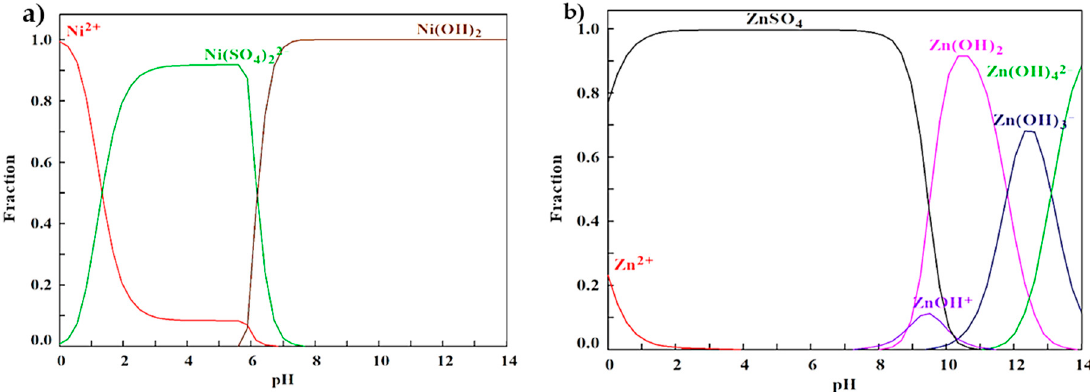
Figure 12. Species distribution diagrams of Ni-Zn/H 2 SO 4 systems containing 0.1836 mol/L Ni ( a ), 0.0662 mol/L Zn ( b ) at 1.5625 mol/L SO 42 − .